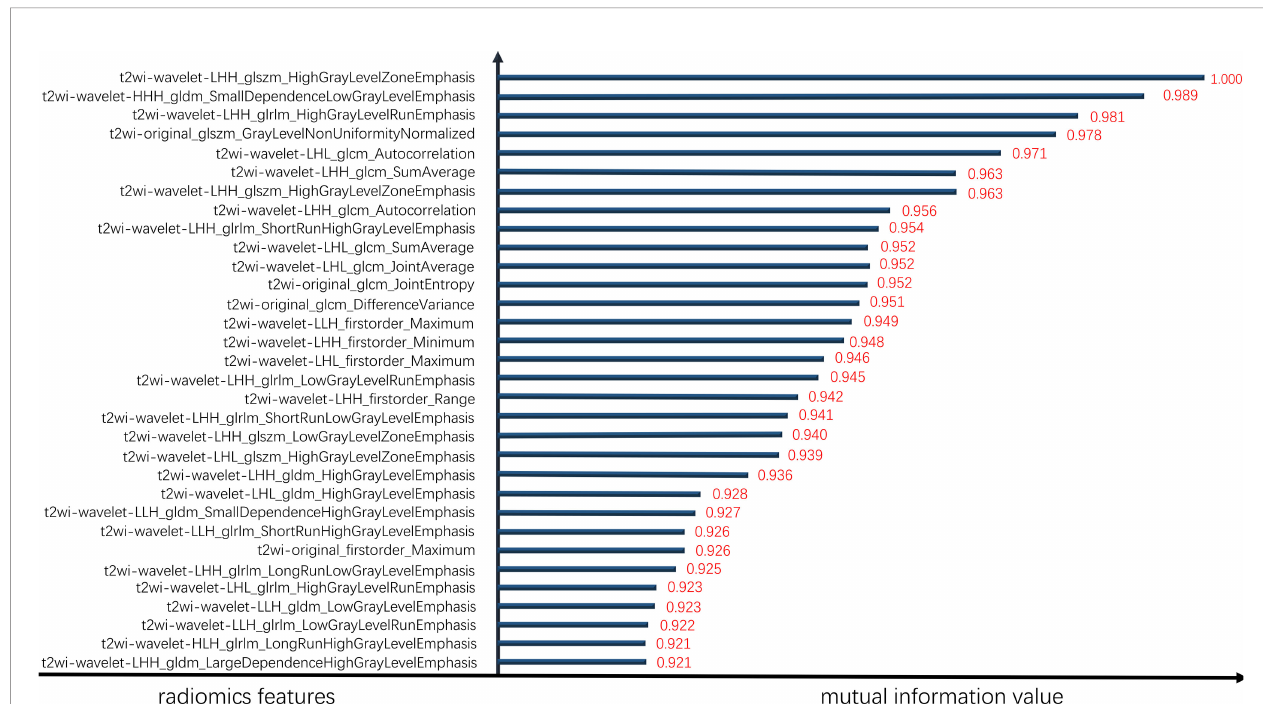
FIGURE 3 | Sorted element mutual information